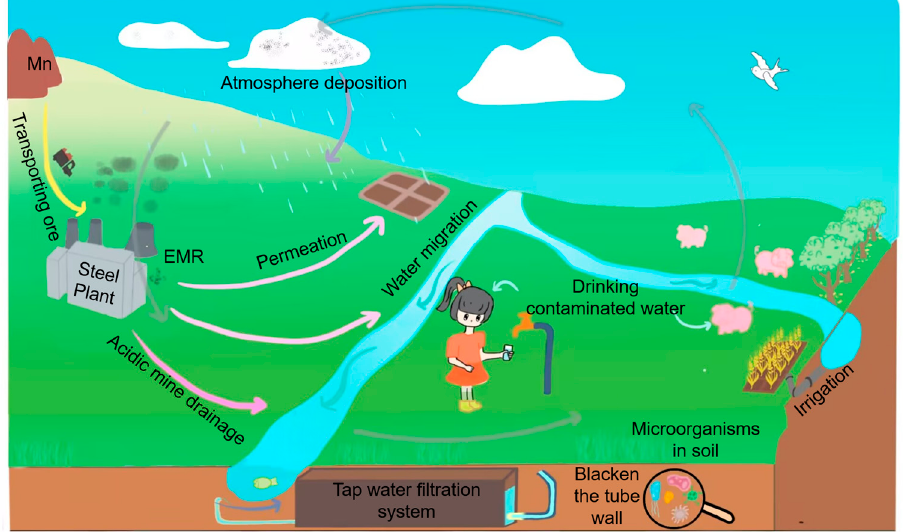
Figure 1. Sources, transfer processes and toxicity of Mn in the biogeochemical cycles.